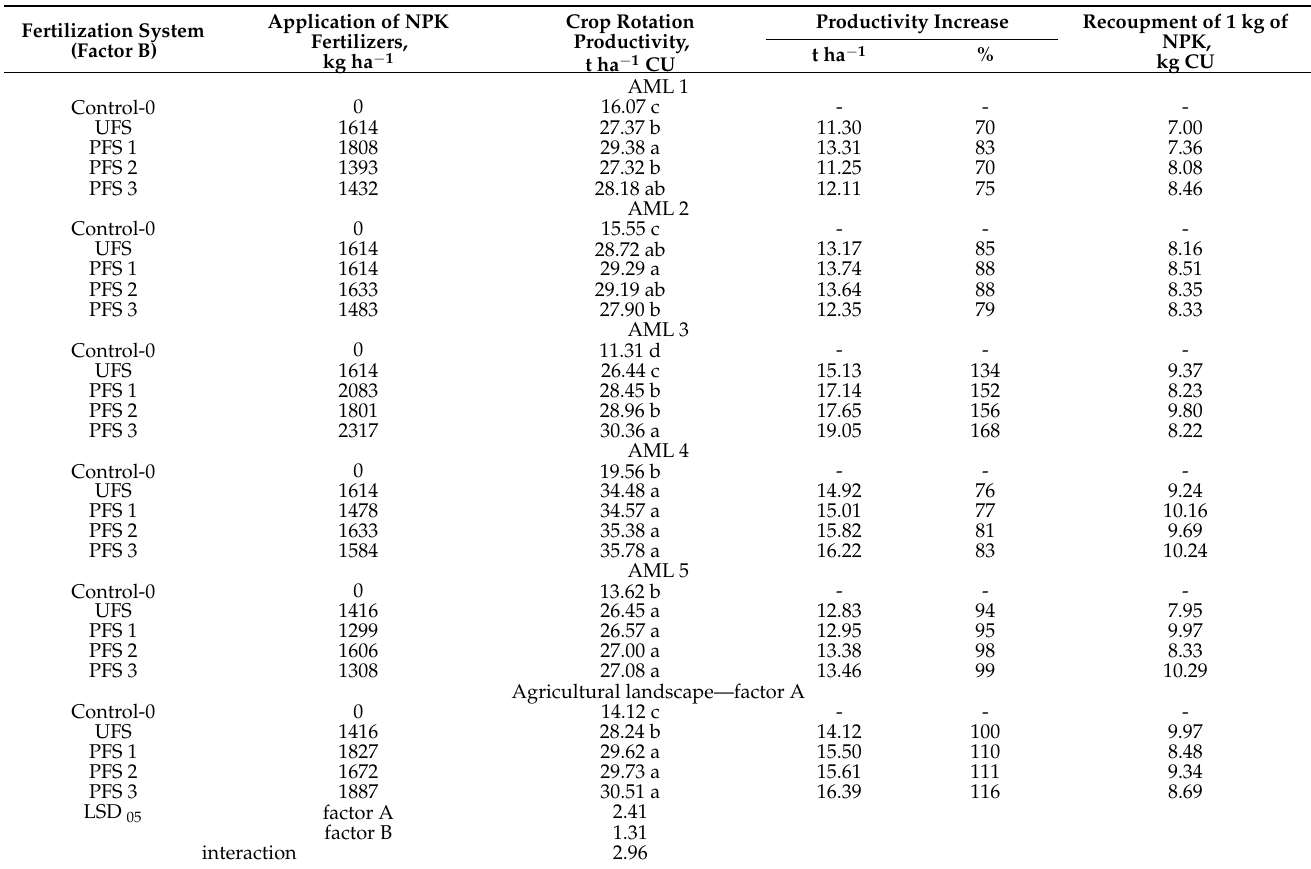
Table 8. Efficiency of the fertilization systems in the field crop rotation. Fertilization System (Factor